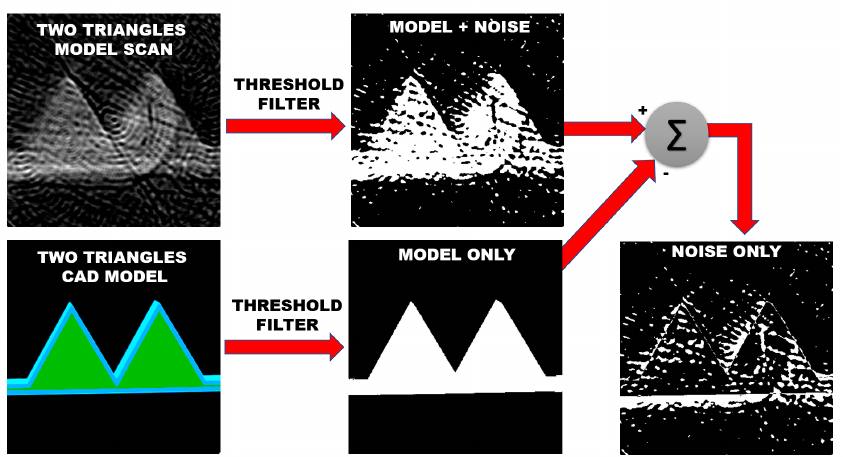
Figure 10. Two Triangles model scan ( Top ) and its original CAD model ( Bottom ) are compared to estimate the noise present in the 3D Immersion Scanning